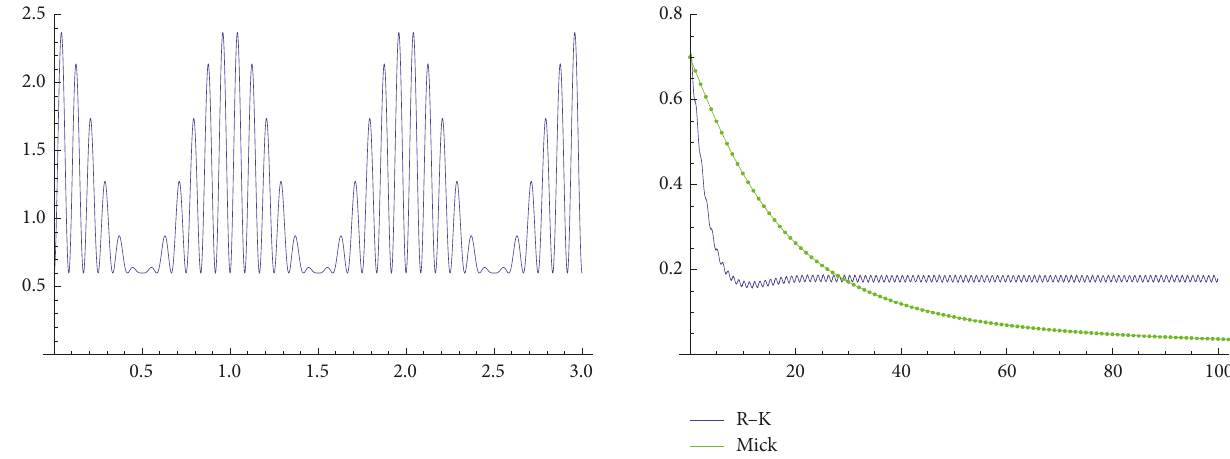
Figure 1: Left: function 𝛽 ; right: inconsistency (time step=1/6).